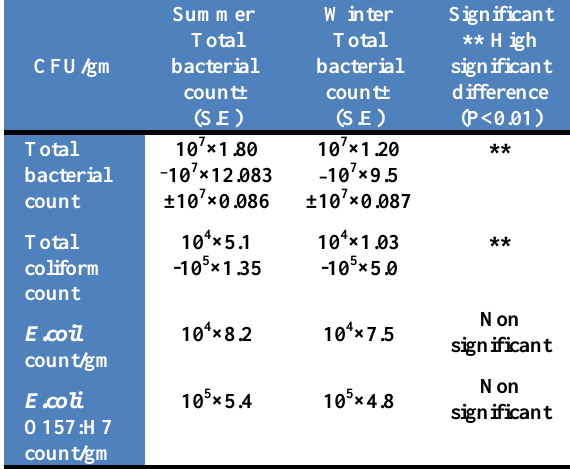
Table, 3: Bacterial isolation of E. coil O157:H7/g of local cheeses sample during the probationary period. Table, 4: compared to the bacterial count of the local Mean of microbial Isolation soft cheese samples for both summer and winter count of E.coil ratio season rates. O157:H7/gm